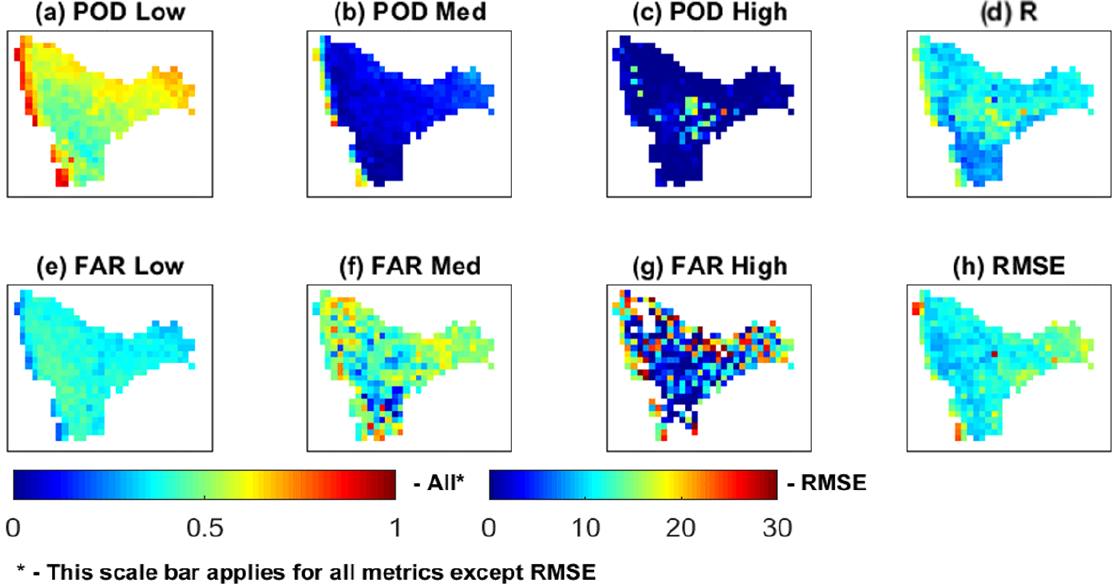
Figure 6. Categorical and continuous statistic metrics depicted for NBR model under combination 4.